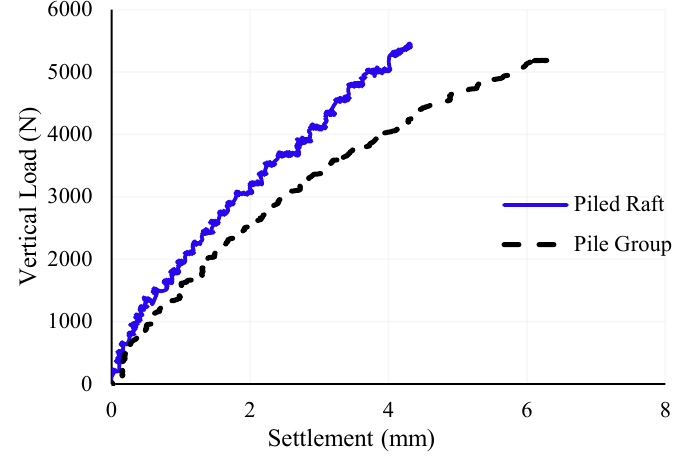
Figure 19. 21-pile group vs. 21-piled raft vertical response.